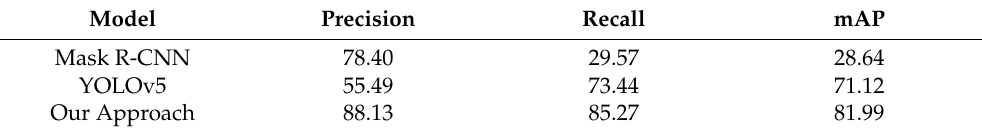
Table 2. Results of 23 classes.